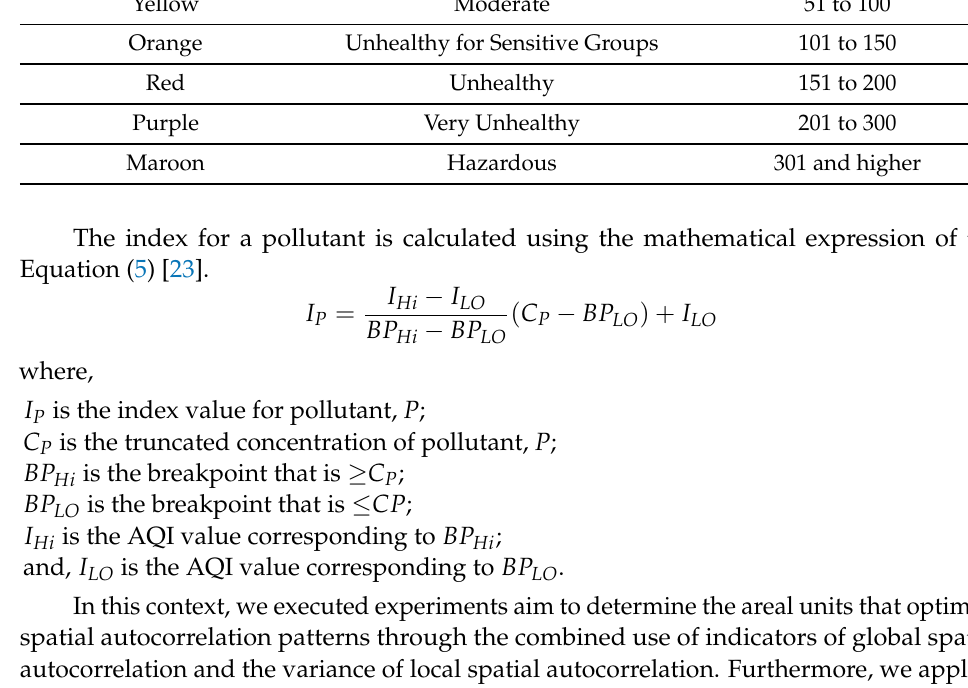
Table 4. AQI basics for Ozone and Particle Pollution. Source: www.airnow.gov/aqi/aqi-basics. AQI Color Levels of Concern Values of Index Green